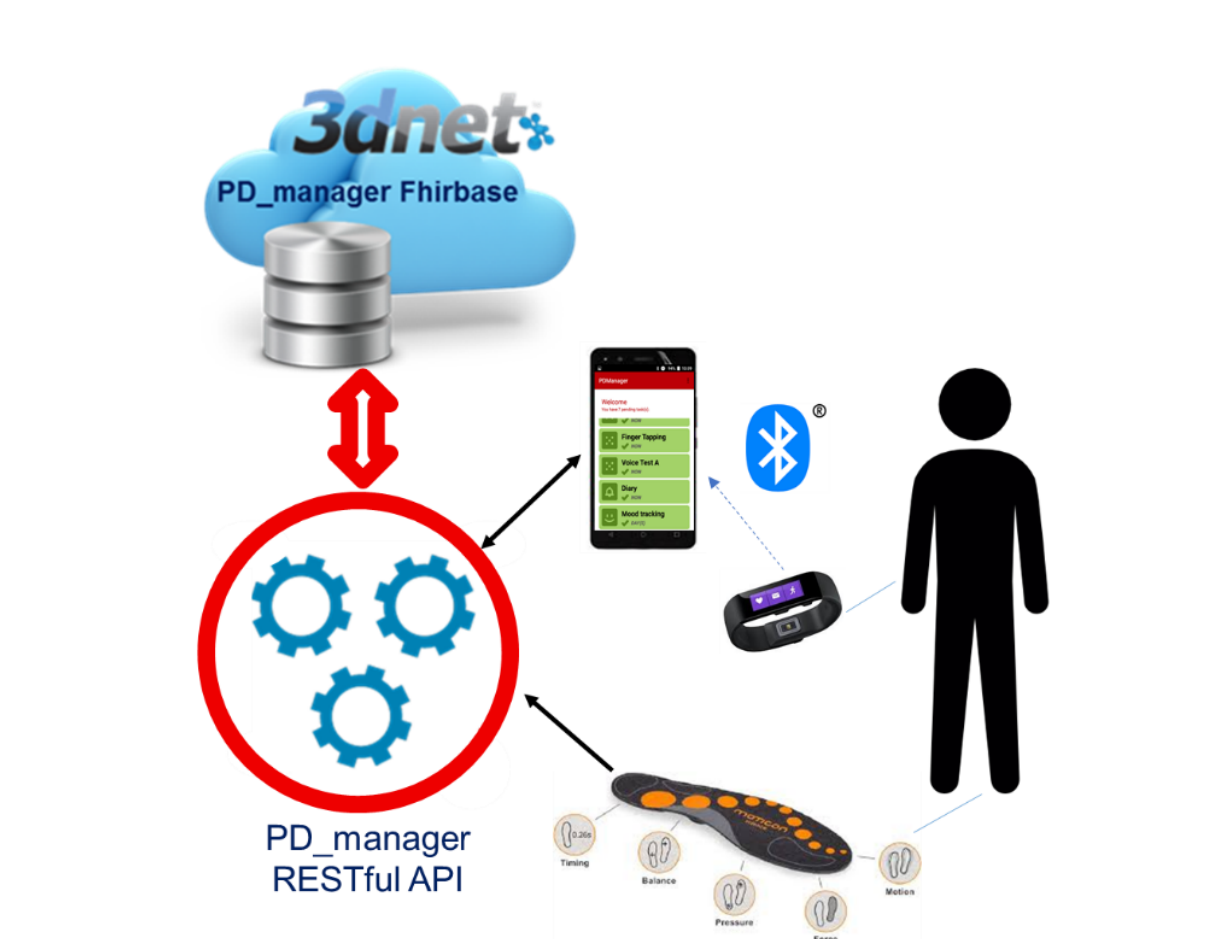
Figure 1. PD_manager mHealth platform overview.